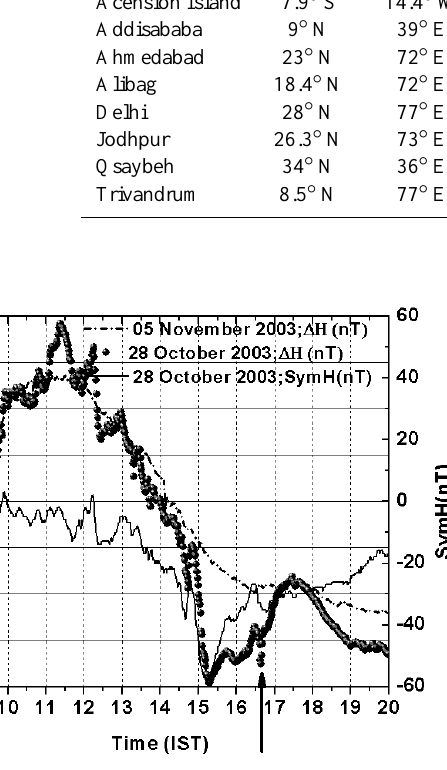
Fig. 1. The temporal variation of 1H at Trivandrum for 28 October 2003 (solid spheres) and the sample quiet day of 5 November 2003 (dashed line) along with the corresponding SymH variations (solid line) for 28 October 2003.